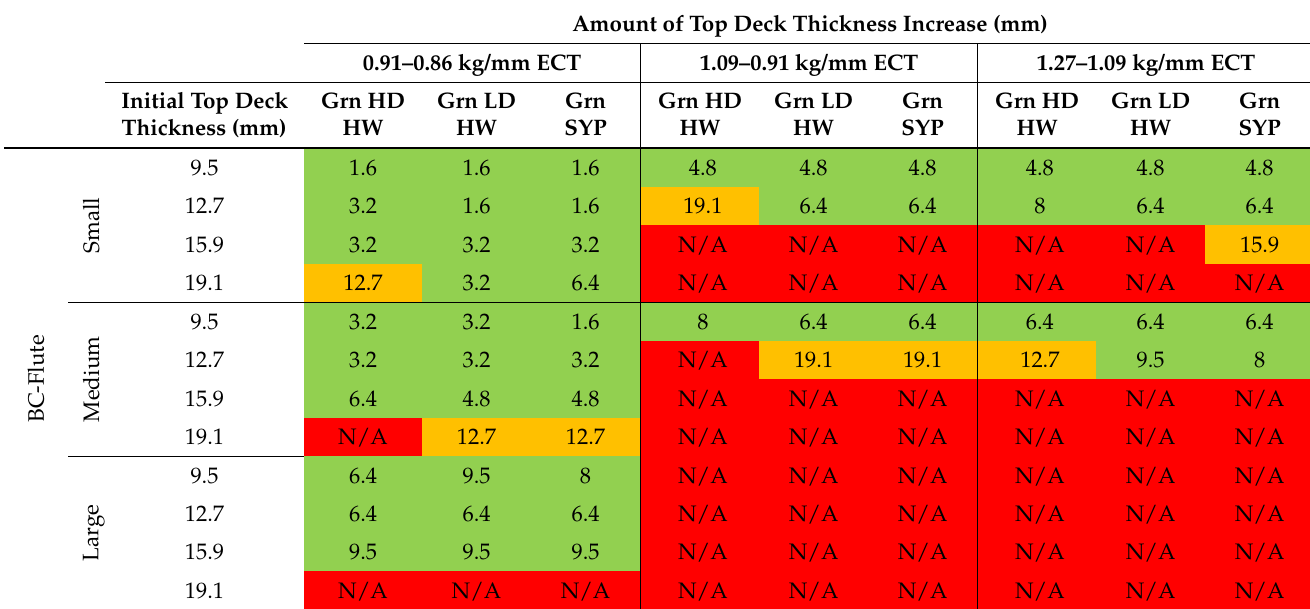
Table 5. The amount of top deck board thickness required to optimize unit loads consisting of BC-flute boxes.